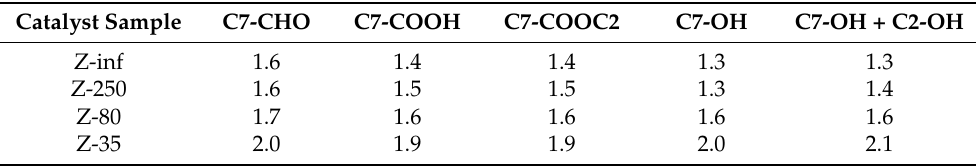
Table 2. C3/C4 carbon yield ratio as dependent on Al content of the H-ZSM-5 samples in the conversion of oxygenates with different functional groups compared to primary